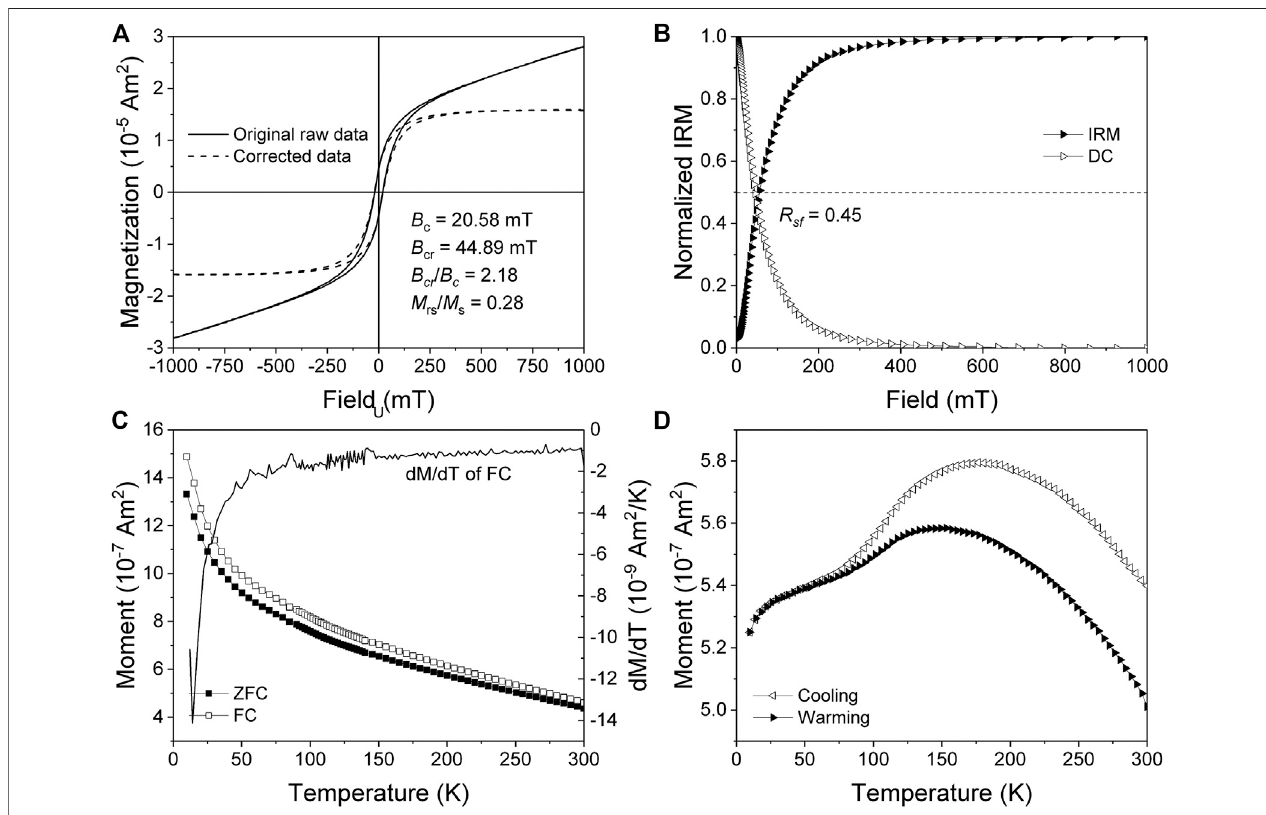
FIGURE 2 | (A) Room-temperature hysteresis loop (solid and dashed lines are the original raw and high- fi eld slope-corrected data, respectively. (B) Normalized IRM acquisition and DCD curves. (C) FC-SIRM 10 K_2.5 T and ZFC-SIRM 10 K_2.5 T warming curves. (D) SIRM 300 K_2.5 T cooling-warming cycle curves.